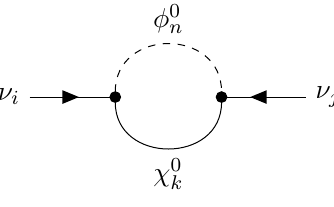
Figure 5 . Feynman diagram associated to the generation of neutrino masses at the one-loop level in the mass eigenbasis. Here, the neutrino indices i, j run over e, µ, τ , the scalar φ 0 ) or CP -odd ( A 0 ), and the fermionic states include χ 0 ( φ 0 , φ 0 1 2